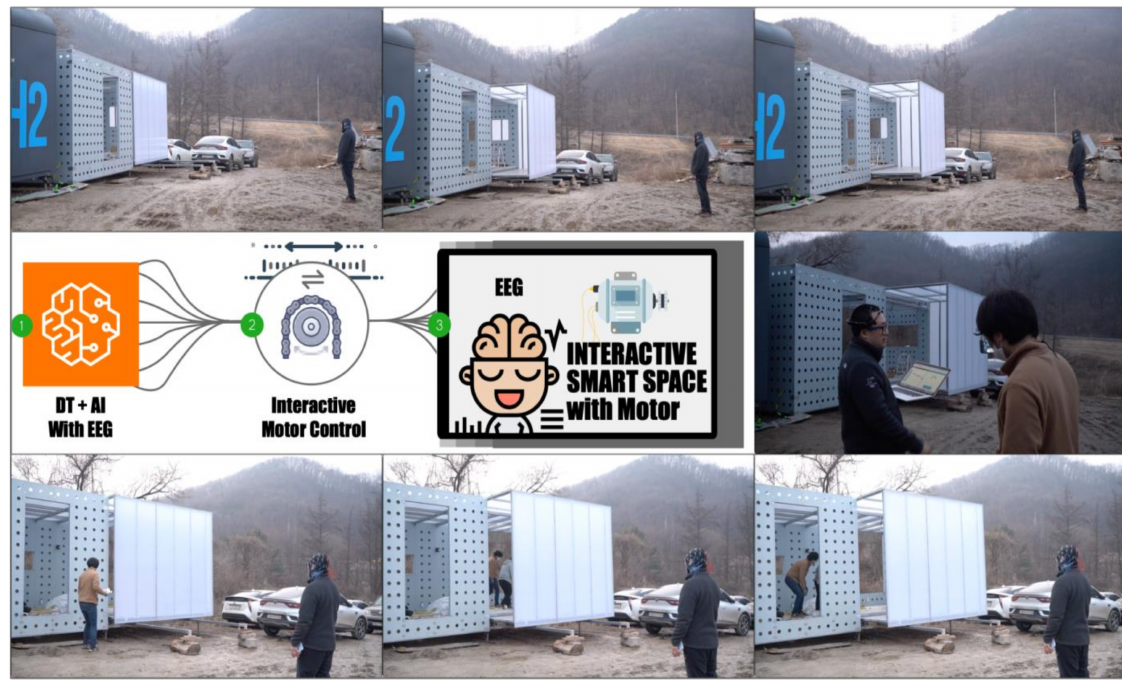
Figure 1. Smart space operation with